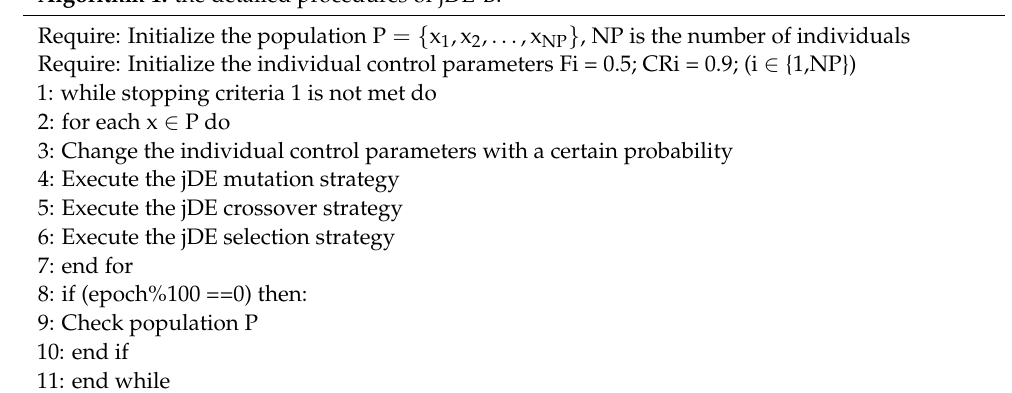
Algorithm 1. the detailed procedures of